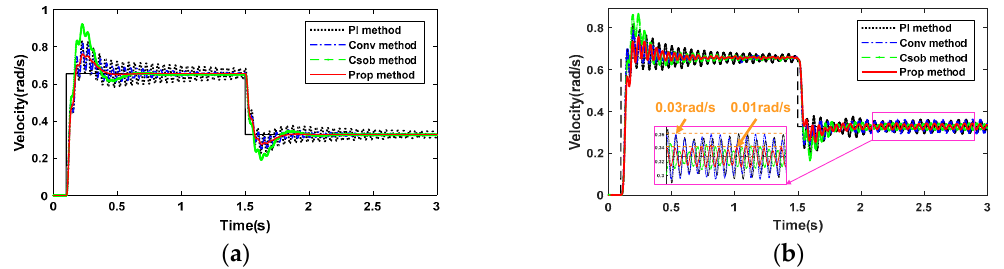
Figure 14. Velocity ripple elimination from 0.66 rad/s reduced to 0.33 rad/s with link-side controller: ( a ) simulations; ( b ) experiments.